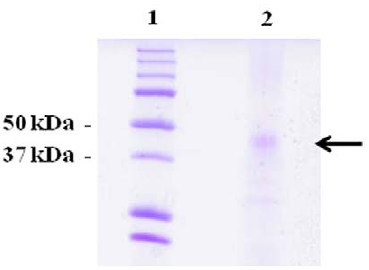
Figure 4. Gel Electrophoresis of Purified Zebrafish Cobalamin Binder. The cobalamin-binding protein purified from zebrafish is shown as a major band with an apparent molecular mass of approximately 40 kDa. Lane 1) marker; Lane 2) purified zebrafish cobalamin binder (see Materials and Methods for details).